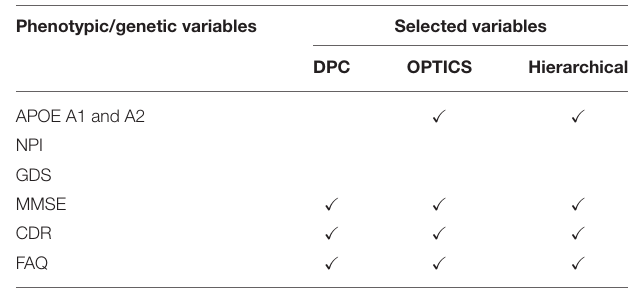
TABLE 2 | Phenotypic variables selected by GA with different clustering methods (AD). Phenotypic/genetic